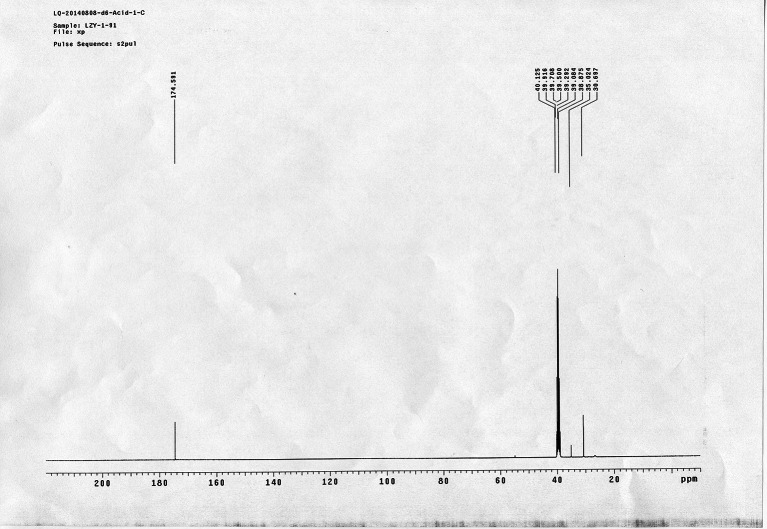
13C NMR spectra of compound 29.